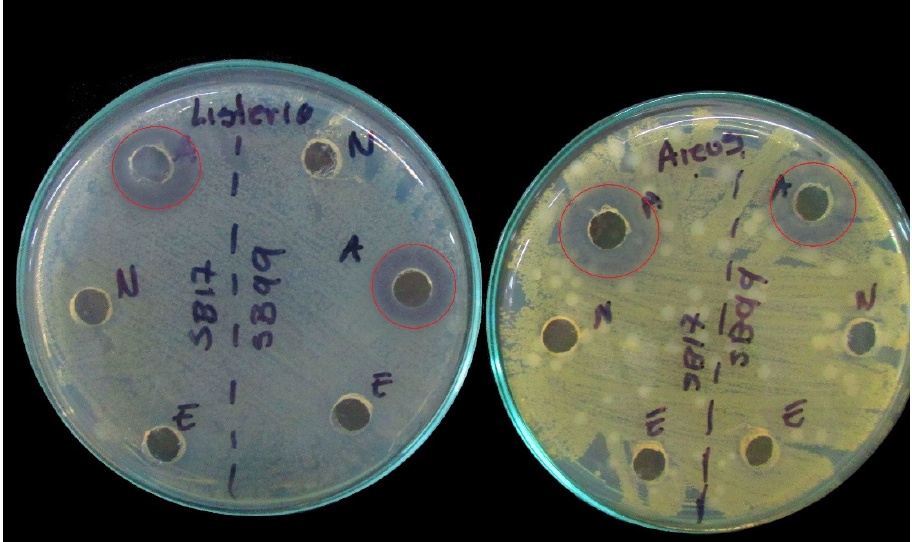
Figure 3. Inhibition results by cell-free extract: the effect of fraction A. Red circles indicate the effect of organic acids on Listeria monocytogenes and Staphylococcus aureus strains. Table 4. Inhibition of three pathogens by isolate